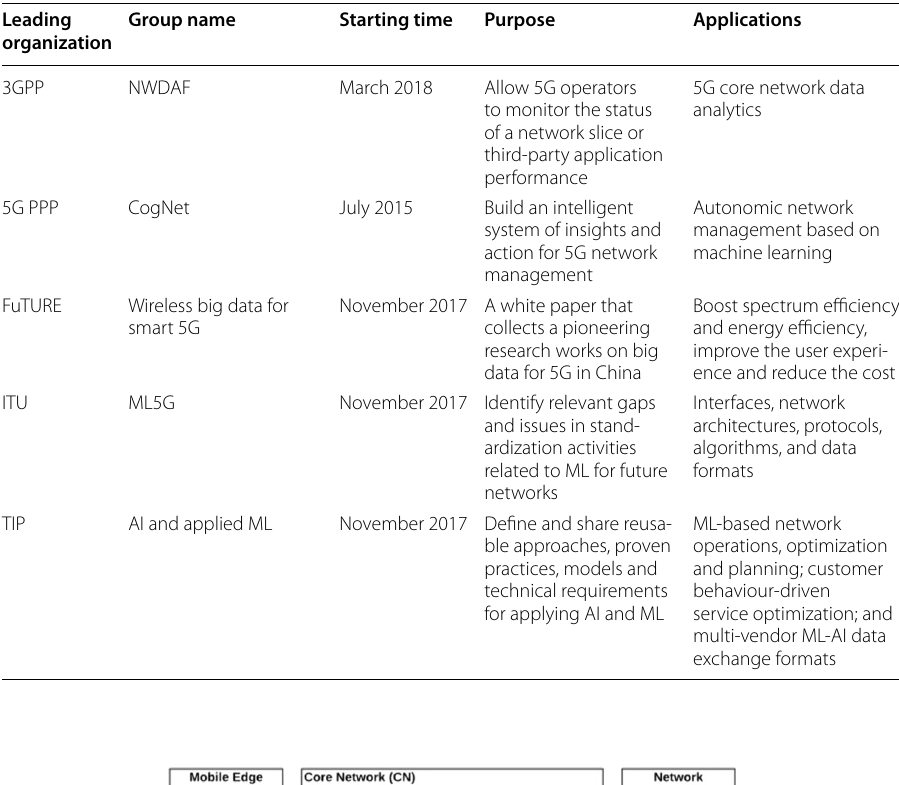
Table 4 AI/ML for 5G networks and beyond in standards [73] Leading Group name organization